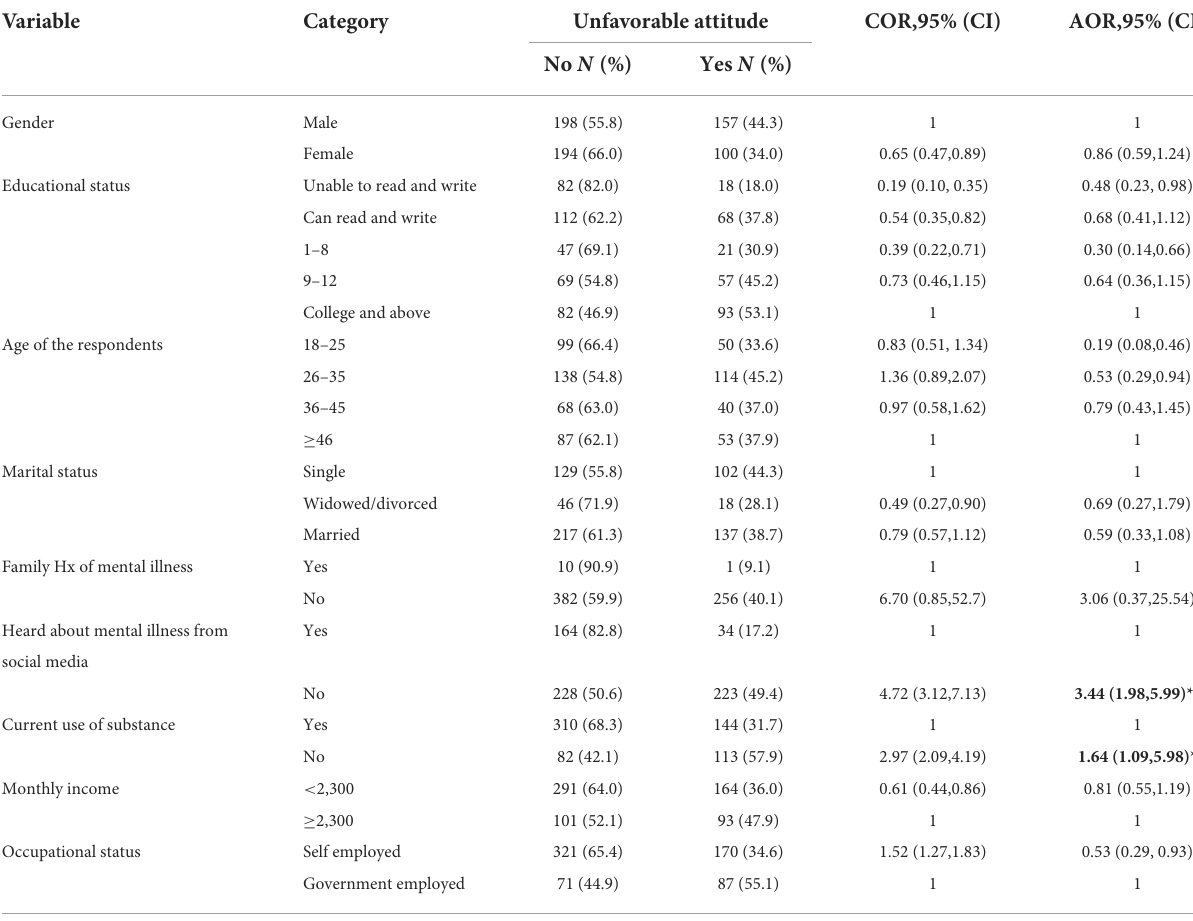
TABLE 3 Bivariate and multivariate logistic regression analysis of factors associated with unfavorable attitude toward mental illness among Mattu town residents, South West Ethiopia, 2022 ( N = 649).